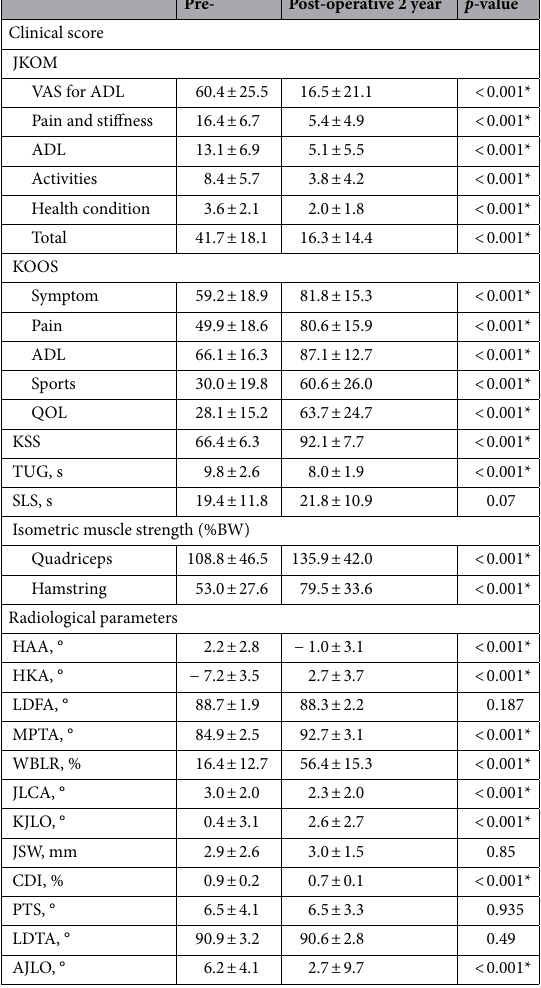
Table 2. Clinical and functional score and radiographic data at pre-opeartive and post-operative 2 year. Data are shown as the means with standard deviation or number. JKOM Japanese Knee Osteoarthritis Measure, VAS visual analogue scale, ADL activities of daily living, KOOS Knee Injury and Osteoarthritis Outcome Score, QOL Quality of Life, KSS Knee Society Score, TUG timed up and go test, SLS single leg stance, HAA hip abduction angle, HKA hip-knee-ankle, FTA femoro-tibial angle, WBLR weight-bearing line ratio, JSW joint space width, PTS posterior tibia slope, CDI Caton-Deschamps index, MPTA medial proximal tibial angle, LDFA lateral distal femoral angle, LDTA lateral distal tibial angle, JLCA joint line convergence angle, KJLO knee joint line obliquity, AJLO ankle joint line